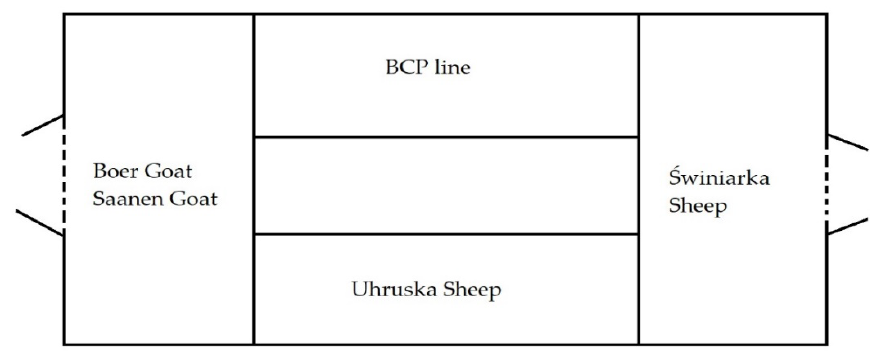
Figure 1. Arrangement of animals in the building (arrangement of pens in the building).